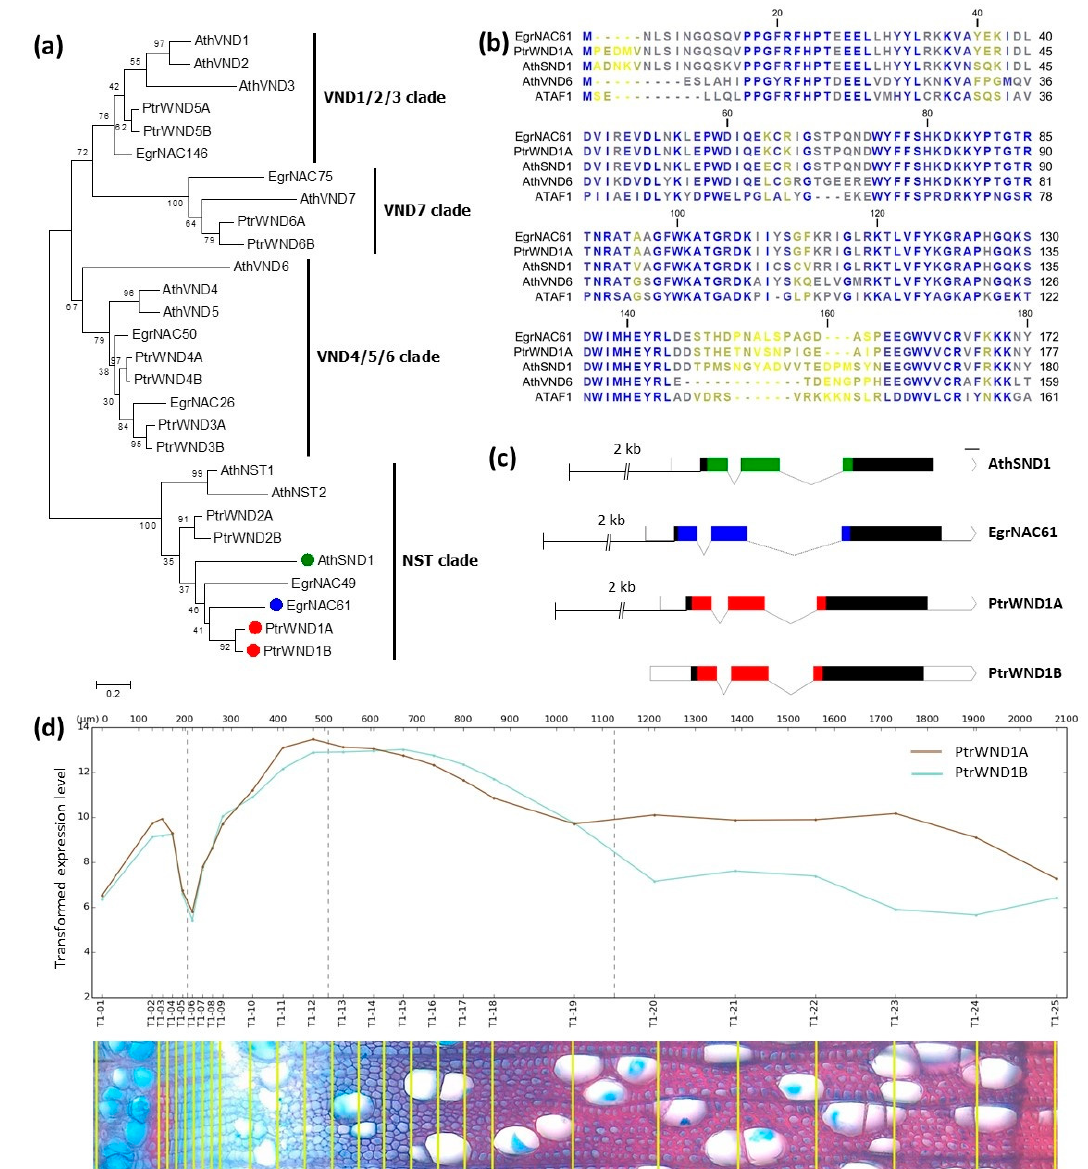
Figure 1. Phylogenetic and sequence analysis of NST and VND proteins. ( a ) Maximum likelihood phylogenetic tree. The tree with the highest log likelihood ( − 7877.59) is shown, drawn to scale, with branch lengths representing the number of substitutions per site. ( b ) Sequence alignment of the NAC domain of EgrNAC61, PtrWND1A and AthSND1. AthVND6 is included as a non-orthologous SWN, while ATAF1 is an outgroup NAC protein not known to regulate secondary cell walls (SCW) formation. Highly conserved residues are indicated in blue, semi-conserved residues in grey and variable residues in yellow. ( c ) Schematic representation of exon-intron structures and targeted promoter regions (where applicable) of the orthologous SND1 promoters in this study. Coloured regions indicate the NAC domain while solid black shading indicates the C-terminal protein region; unshaded regions indicate untranslated regions. Scale bar = 10 amino acids. Eucalyptus grandis and Populus trichocarpa sequences are indicated with the prefixes Ath, Egr or Ptr, and green, blue and red shading, respectively. ( d ) AspWood (adapted from [34] with permission) transcript abundance profile of PtrWND1A and PtrWND1B . Micrograph measurements (in µ m) are given on the upper edge of the